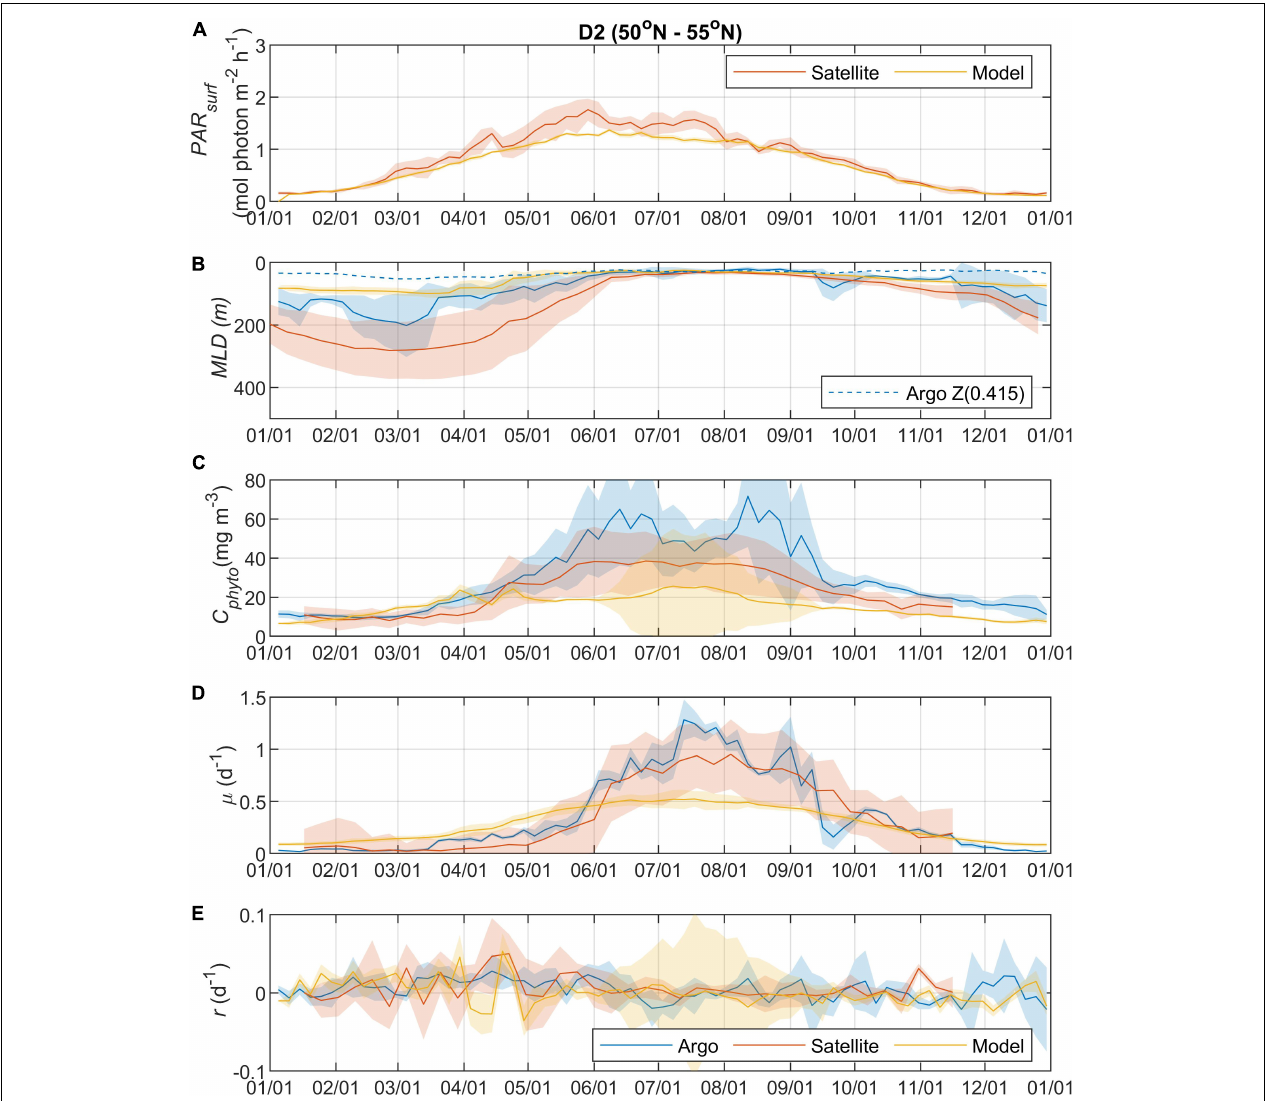
FIGURE 3 | Seasonal climatologies of (A) PAR surf , (B) MLD , (C) C phyto , (D) µ , and (E) r from Argo floats, satellite, and model simulation for region D2. See the caption of Figure 2 for details.